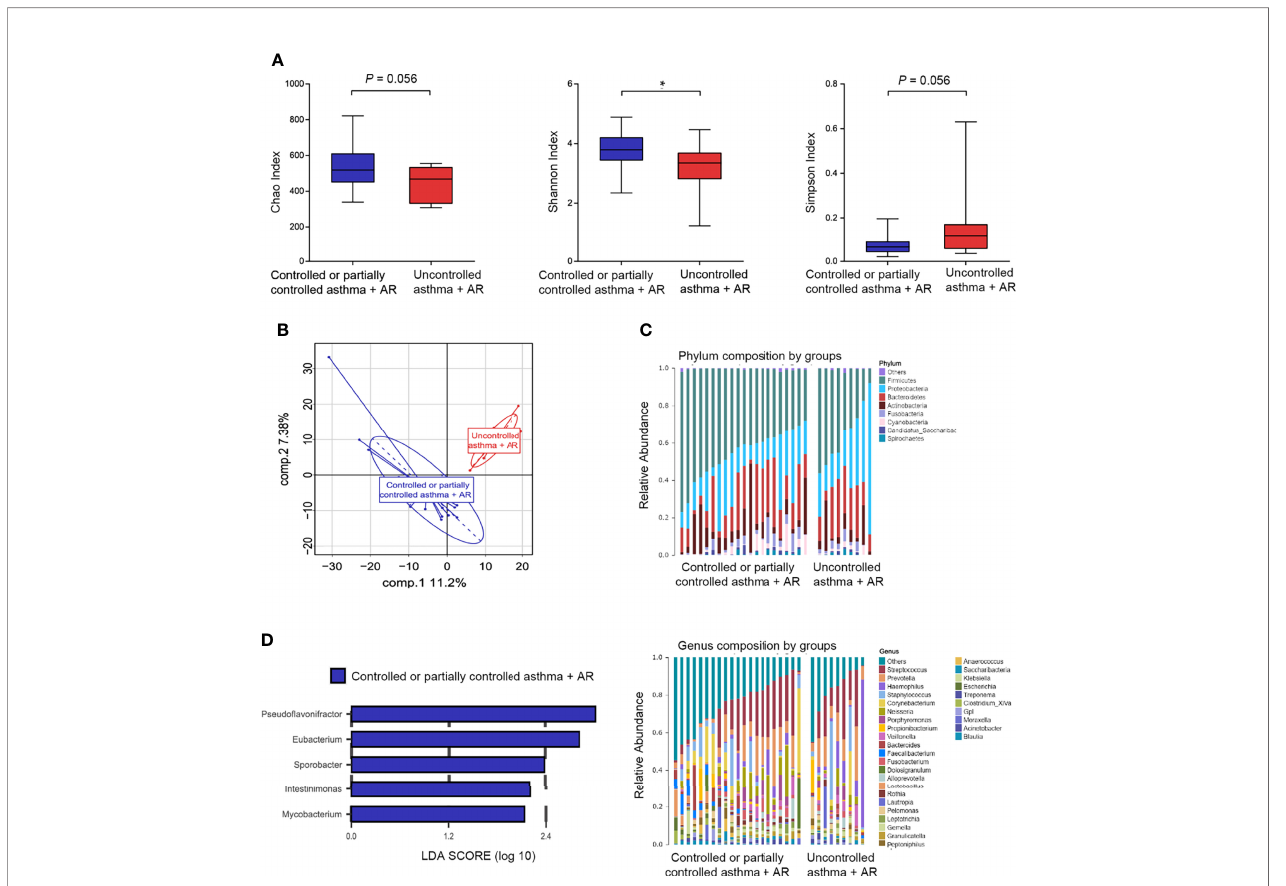
FIGURE 6 | Nasal microbiome composition in combined asthma+AR according to disease control. (A) Box plots of the a -diversity in combined asthma+AR group based on different disease control (Left plot, Chao index; middle plot, Shannon index; right plot, Simpson index). (B) b -diversity based on PLS-DA analysis in combined asthma+AR according to disease control. (C) Bar plots of the phylum and genus taxonomic levels in combined asthma+AR group based on asthma control. (D) LDA score computed for genera signi fi cantly abundance in combined asthma+AR group based on asthma control (LDA Score > 2.0). P < 0.05 was considered as statistically signi fi cant, *P <